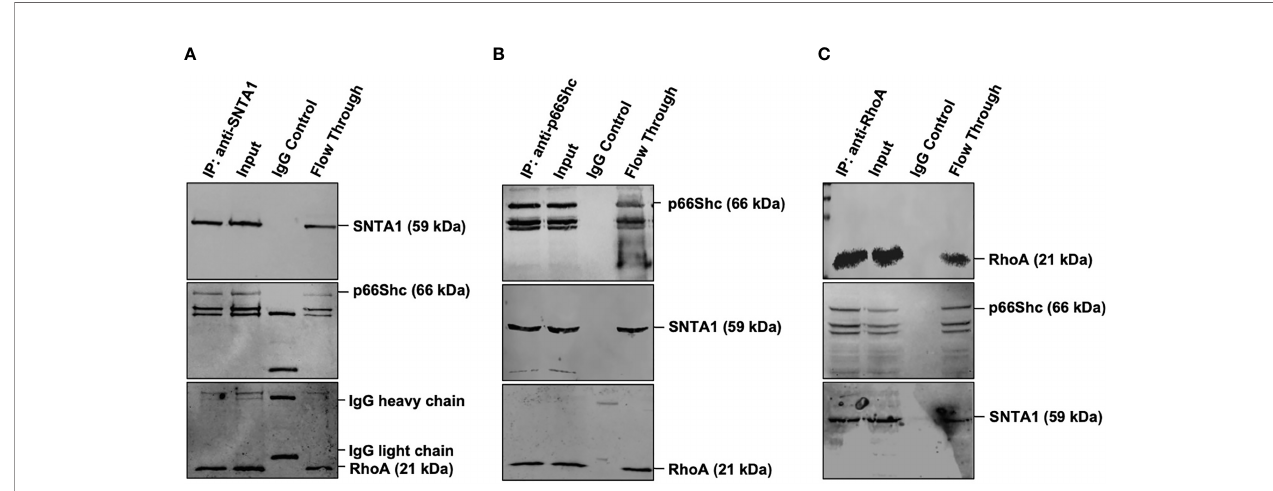
FIGURE 2 | Endogenous SNTA1, p66Shc and RhoA form a stable trimeric complex in MDA-MB-231 cells. (A) Co-immunoprecipitation analysis of the interaction between SNTA1, p66Shc and RhoA in MDA-MB-231 cell extracts. IP: immunoprecipitation, Input: total cell lysate, WB: western blot analysis. IgG was used as a control IP. Pull down of the endogenous SNTA1 protein complex was performed using mouse monoclonal SNTA1 antibody. SNTA1, p66Shc and RhoA proteins were detected after western blotting the resulting immunoprecipitates using the rabbit polyclonal SNTA1 antibody, mouse monoclonal Shc antibody and mouse polyclonal RhoA antibody respectively. (B) Reciprocal immunoprecipitation analysis of the interaction between p66Shc, SNTA1, and RhoA in MDA-MB-231 cell extracts. IP: immunoprecipitation, Input: total cell lysate, WB: western blot analysis. IgG was used as a control IP. Pull down of the endogenous p66Shc protein complex was done using mouse monoclonal Shc antibody in MDA-MB-231 cells. P66Shc, SNTA1, and RhoA proteins were detected after western blotting the resulting immunoprecipitates using rabbit polyclonal Shc antibody, rabbit polyclonal SNTA1 antibody and rabbit polyclonal RhoA antibody respectively. (C) Reciprocal immunoprecipitation analysis of the interaction between RhoA, p66Shc, and SNTA1 in MDA-MB-231 cell extracts. IP, immunoprecipitation; Input, total cell lysate; WB, western blot analysis. IgG was used as a control IP. Pull down of the endogenous RhoA protein complex was done using mouse polyclonal RhoA in MDA-MB-231 cells. RhoA, p66Shc and SNTA1 proteins were detected after western blotting the resulting immunoprecipitates using mouse polyclonal RhoA antibody, rabbit polyclonal Shc antibody and rabbit polyclonal SNTA1 antibody